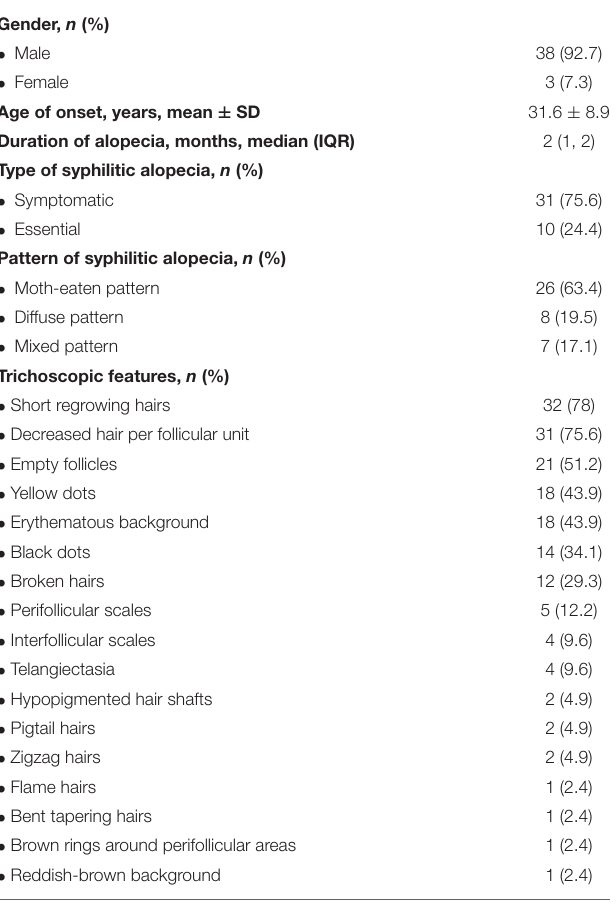
TABLE 4 | Pooled analysis of present study and the literature regarding demographics, clinical characteristics, and trichoscopic features of syphilitic